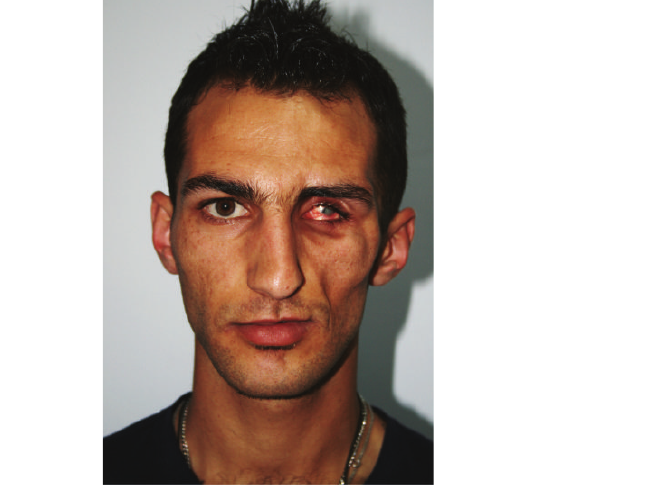
Figure 2: Frontal view of the patient at 23 years of age, showing severe atrophy of fat and muscle tissue, and of the zygomatic arch on the left side, as well as shrinkage of the left eyeball and corneal